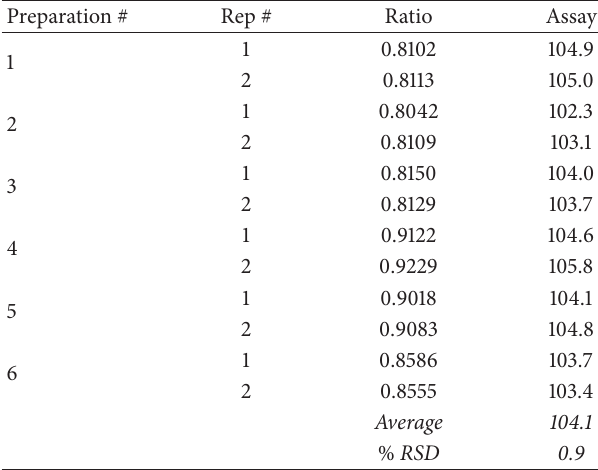
Table 5: Method precision